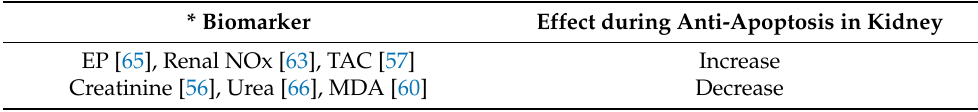
Table 1. The expression of the biomarkers during apoptosis for kidneys. * Biomarker Effect during Anti-Apoptosis in Kidney